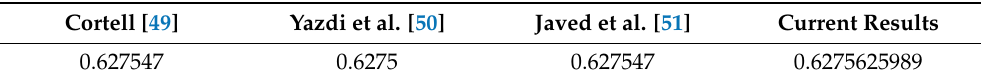
Table 2. Comparison of the shear stress ( | F (cid:48)(cid:48) ( 0 ) | ) value for the first branch solution (FBS) due to the limiting case of the stretching parameter ε r = 1.0 when f w = 0, Γ = 0, Λ a = 0, Σ a = 0, φ a = 0, φ b = 0, and without the influences of stagnation point ( u r → 0 as y r → ∞ ) .